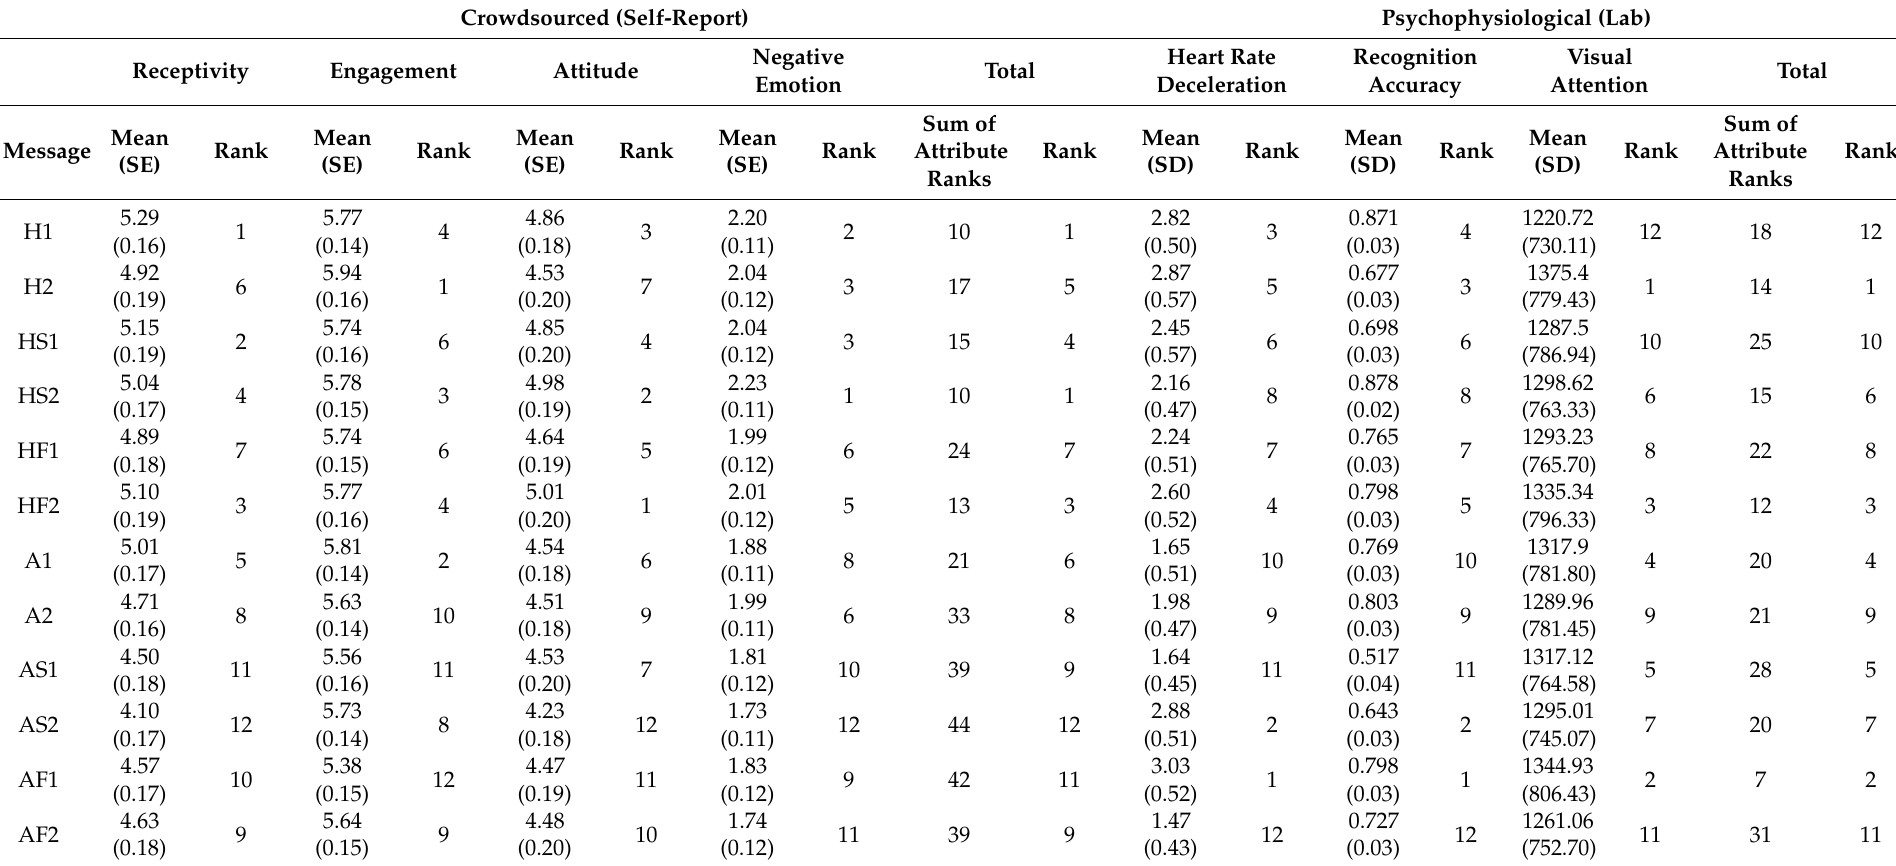
Table 1. Multi-Attribute Decision Matrix for Crowdsourced and Psychophysiology Waterpipe Tobacco Smoking Message Testing. Crowdsourced